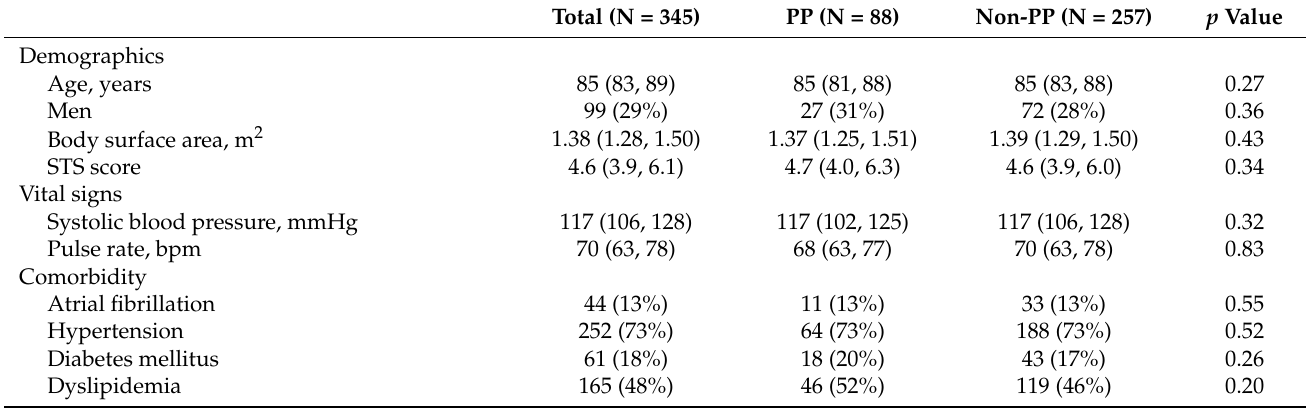
Table 1. Baseline characteristics at index